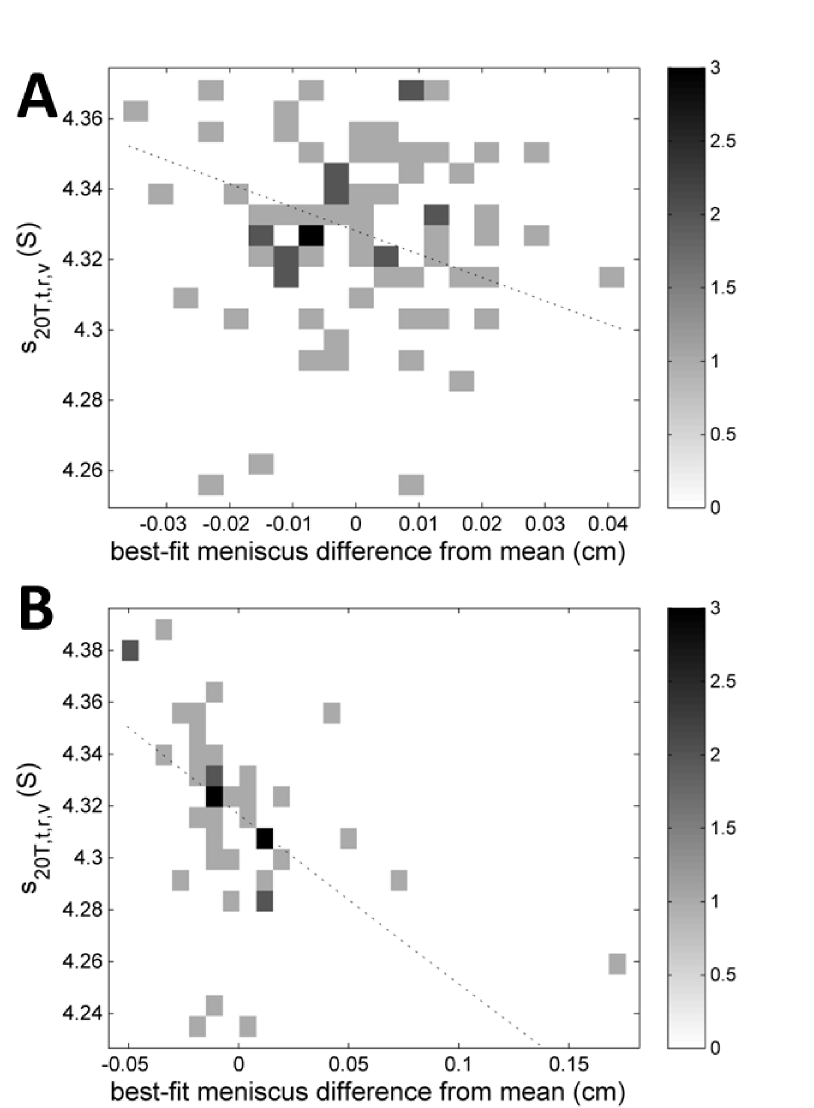
Fig 10. Correlations of the s 20T , t , r , v -values of the BSA monomer with the difference of the best-fit meniscus from the mean meniscus value, separately for absorbance data sets (A) and interference data sets (B). The difference of the best-fit meniscus to the mean was calculated separately for each kit, to eliminate offsets due to different sample volumes in each kit, and then merged into groups for the optical systems. Data are shown as a histogram with frequency values indicated in the colorbar. The dotted lines show the theoretically expected dependence of the apparent s -value on errors in the absolute radial position.